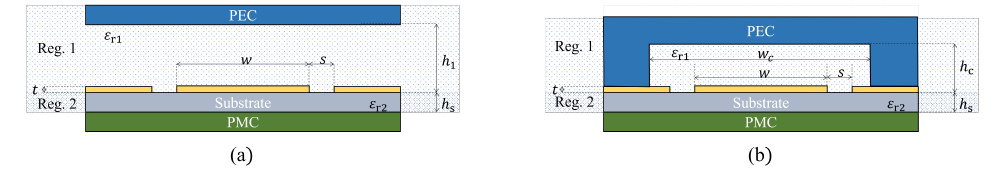
Figure 3. Geometry of the proposed lines. ( a ) Gap Coplanar Waveguide (GapCPW) with a possible top encapsulation. ( b ) Inverted Gap Coplanar Waveguide (IGCPW). Conductor thickness, t , is neglected in the